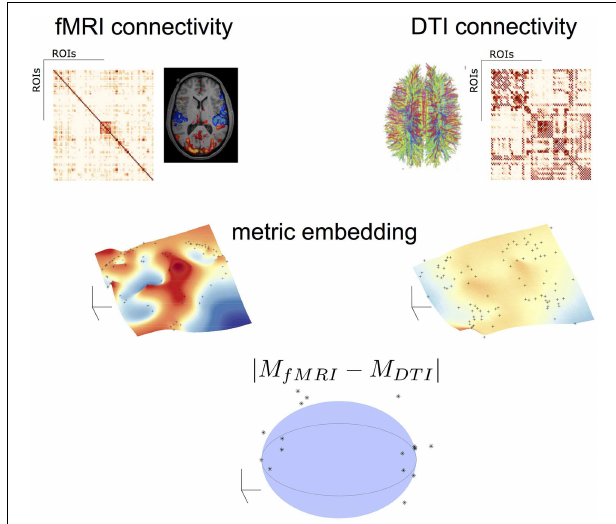
FIGURE 2 | Topological algebraic networks comparison. Connectivity from different modalities (here fMRI and DTI) are firstly embedded (black dot points on the manifolds indicate the brain nodes) and then compared in a low-dimensional space. Black points outside the sphere correspond to nodes with a topological difference (at a given threshold) in the two modalities.